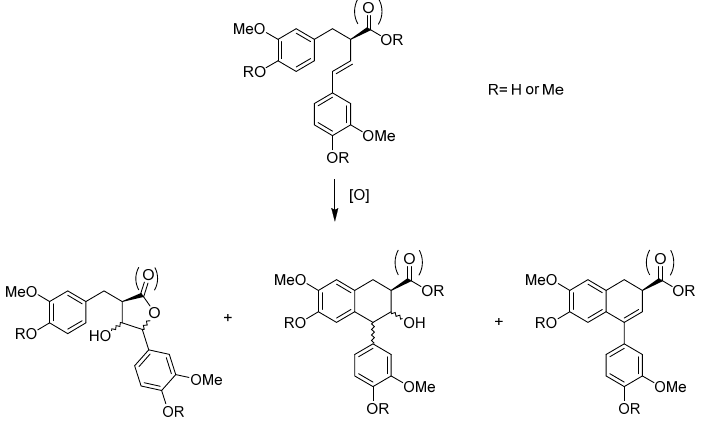
Figure 15. Schematic representation of the oxidation products of 9-norlignans, tetrahydrofuronato-, aryltetralin, and butyrolactones norlignans.